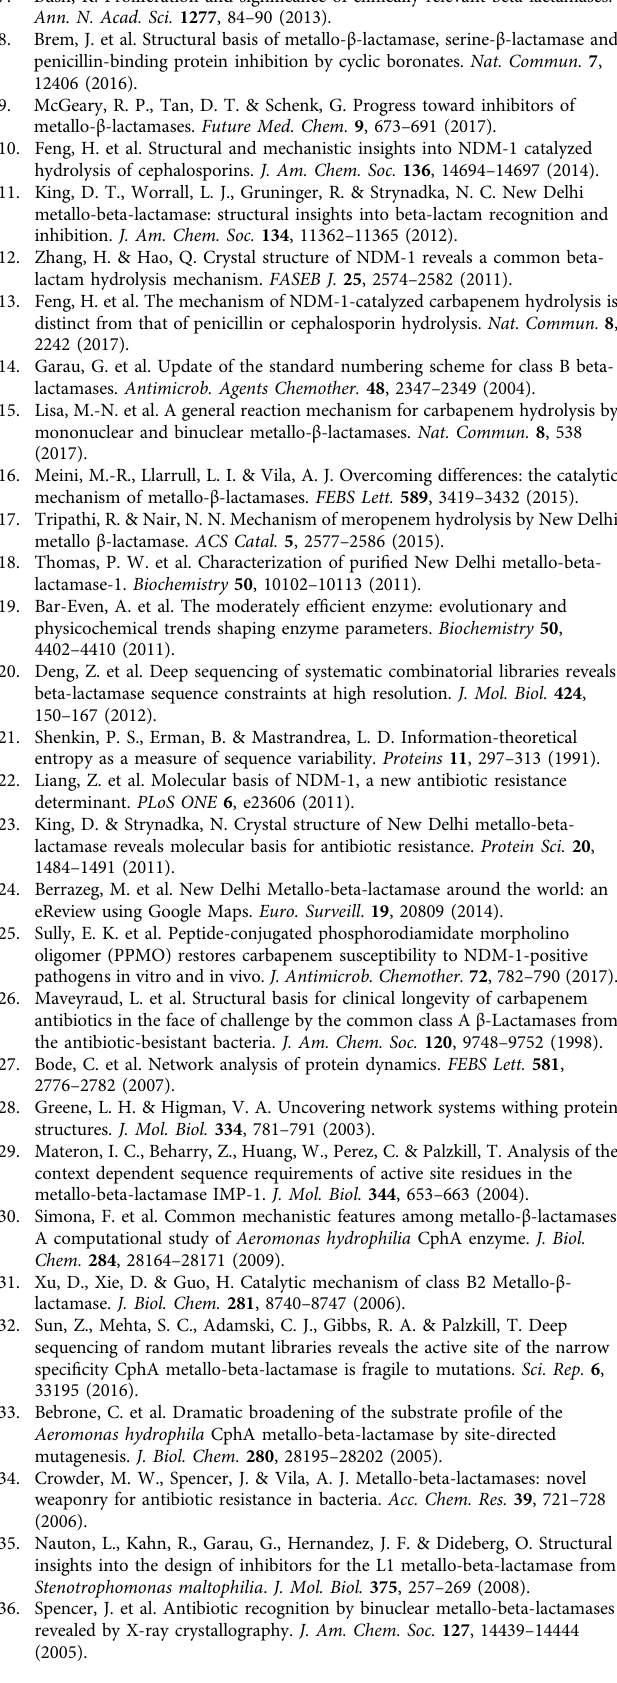
Table. 4 Data collection and re fi nement statistics for